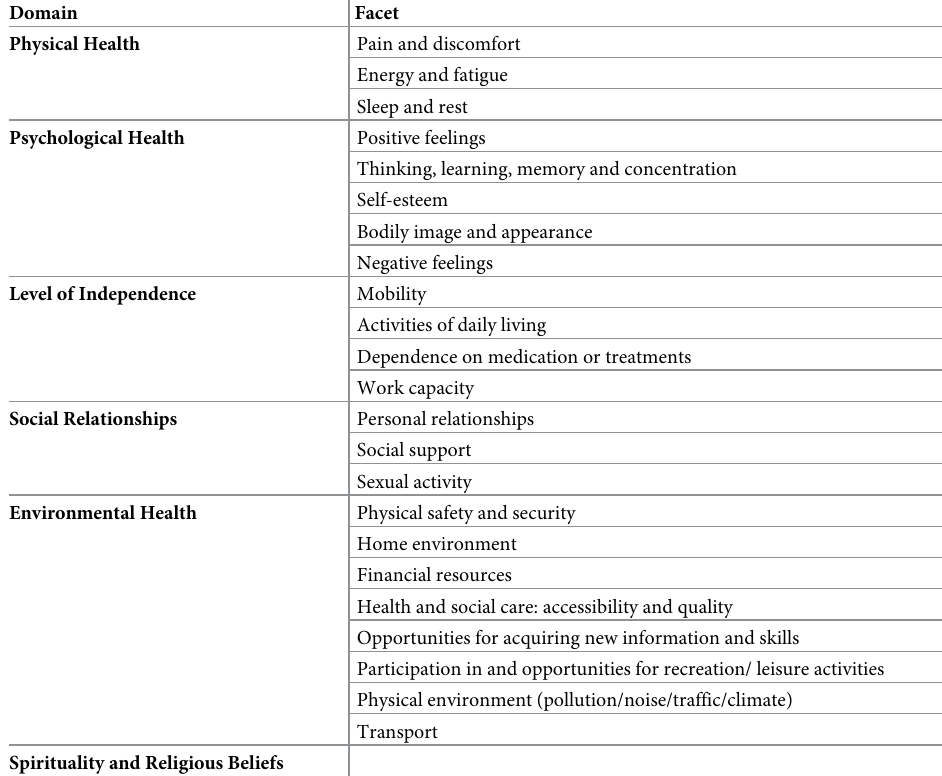
Table 1. Structure of the World Health Organization (WHO) QOL domains and